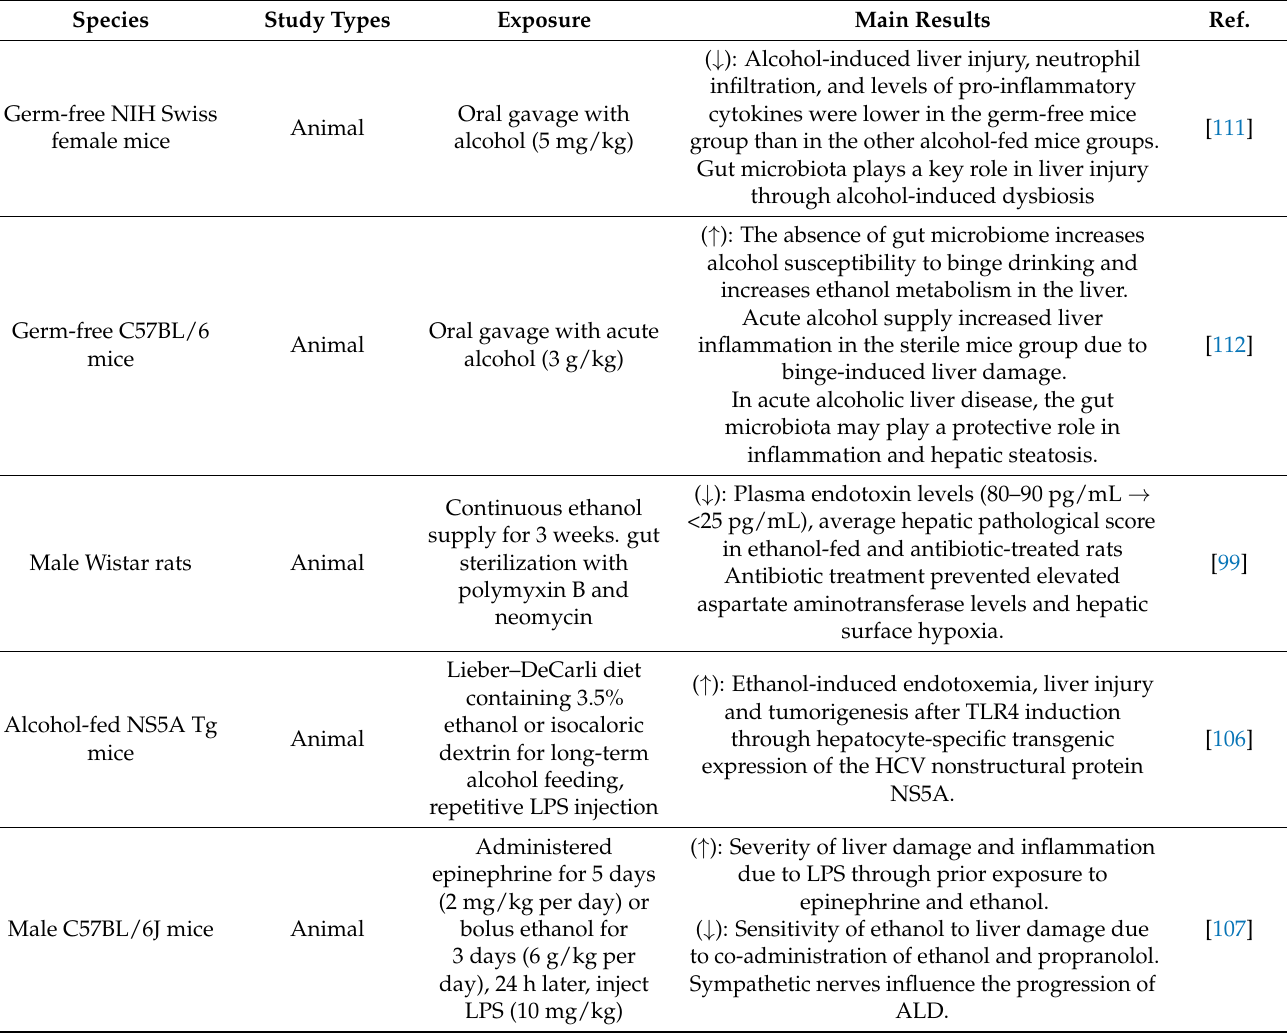
Table 2. Alcoholic liver disease studies related to the immune